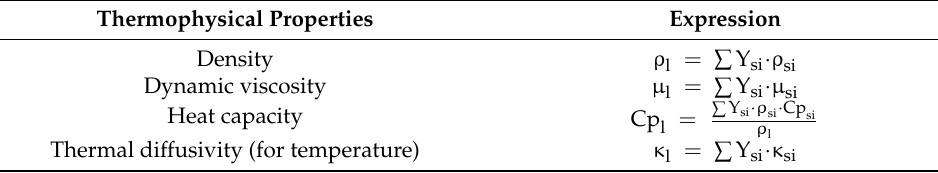
Table 1. Mixture